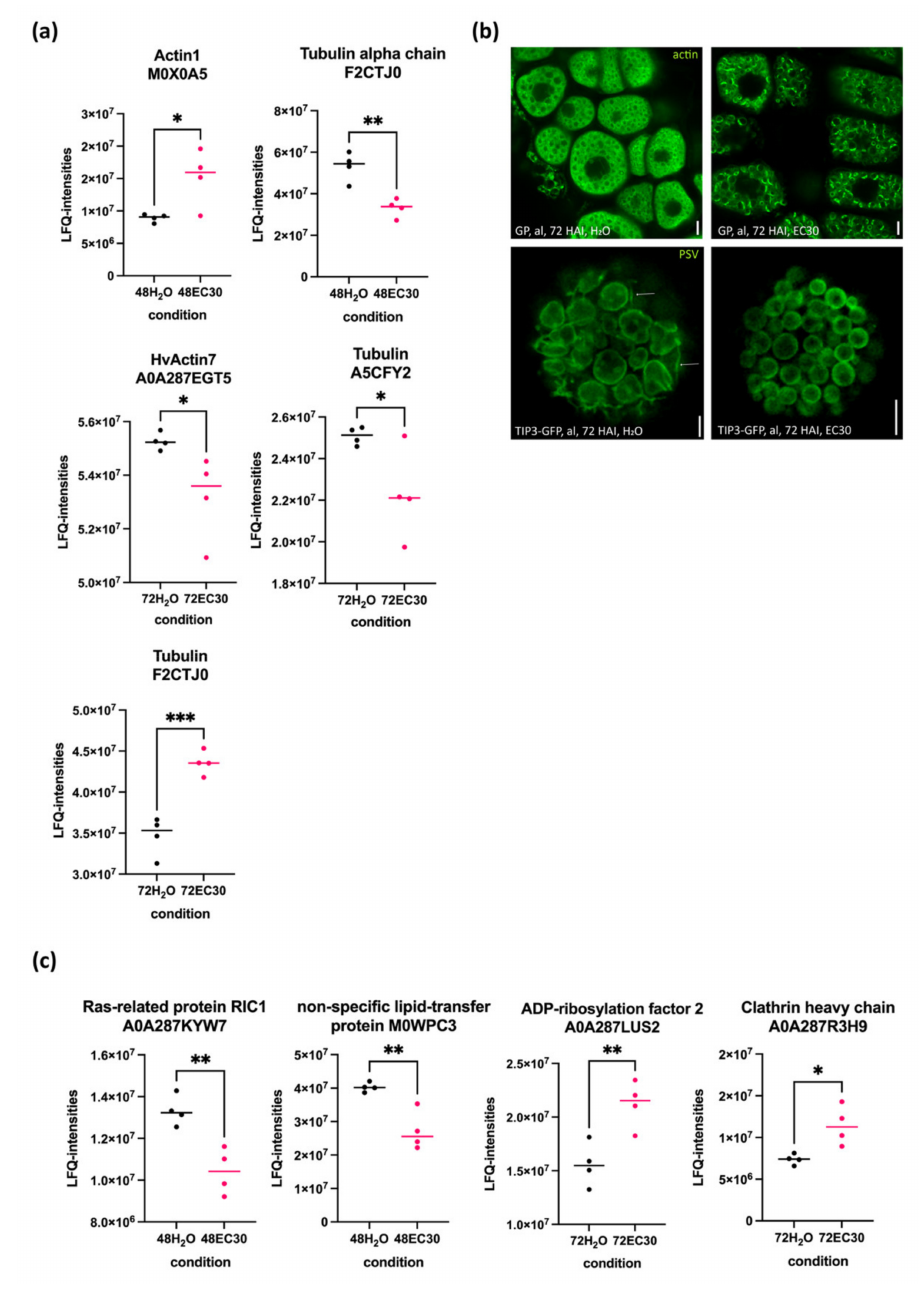
Figure 7. The abundance of proteins (LFQ-intensities) involved in protein trafficking and cytoskeleton-associated proteins in the endosperm when germinated in H 2 O and EC30 at 48 and 72 HAI. ( a ) The abundance of cytoskeleton-associated proteins at 48 and 72 HAI when germinated at 30 EC. ( b ) Confocal micrographs of actin using CellMask TM Green Actin Tracking Stain (1:500 dilution of a 1000X stock solution). Note the tubular structures of PSVs in H 2 O but not in EC30. ( c ) The abundance of four proteins involved in protein trafficking at 48 and 72 HAI. Scale = 5 µ m. Statistical analyses: multiple-unpaired t-test; significance is indicated with * ( p -value ≤ 0.05), ** ( p -value ≤ 0.01), and *** ( p -value ≤